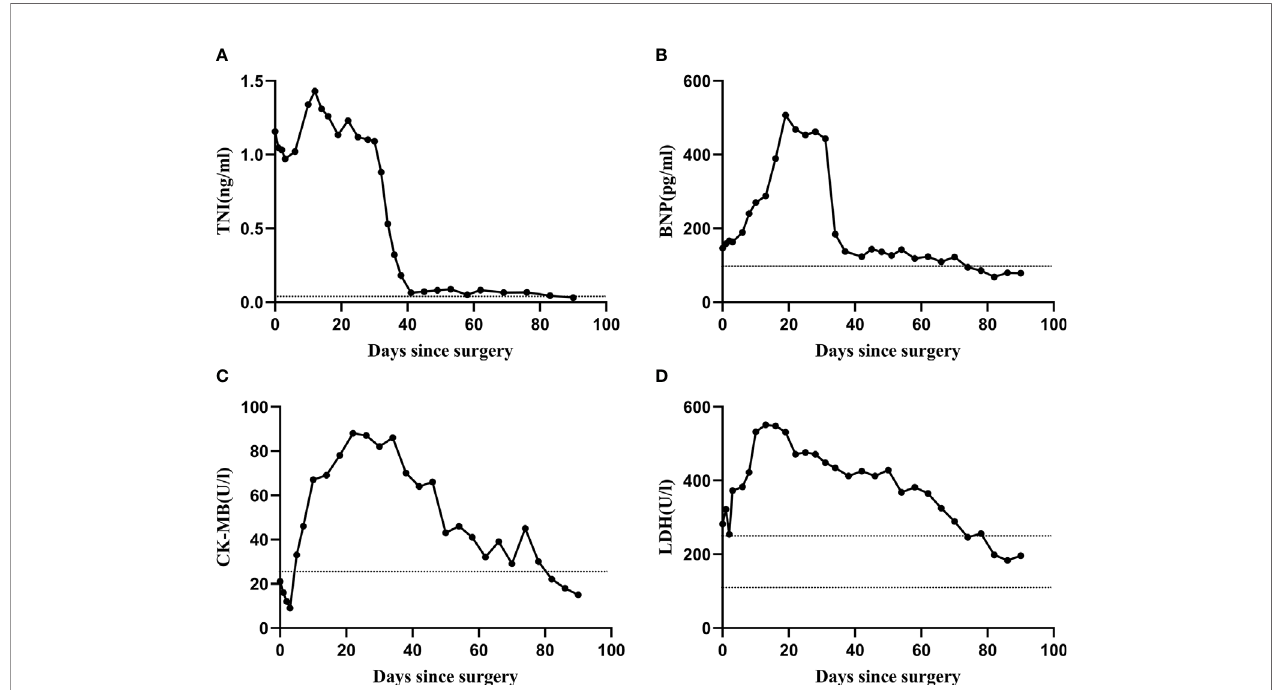
FIGURE 2 | The trends of laboratory test results. The levels of TNI, BNP, LDH, and CK-MB were mildly higher than normal before surgery, signi fi cantly increased within 10 days after tumor resection, and 3 months later, returned to be normal (A – D) . Horizontal dashed black lines in each graph designate the upper and lower limits of the normal range for each variable, as determined by the Beijing Tongren Hospital Clinical Hematology